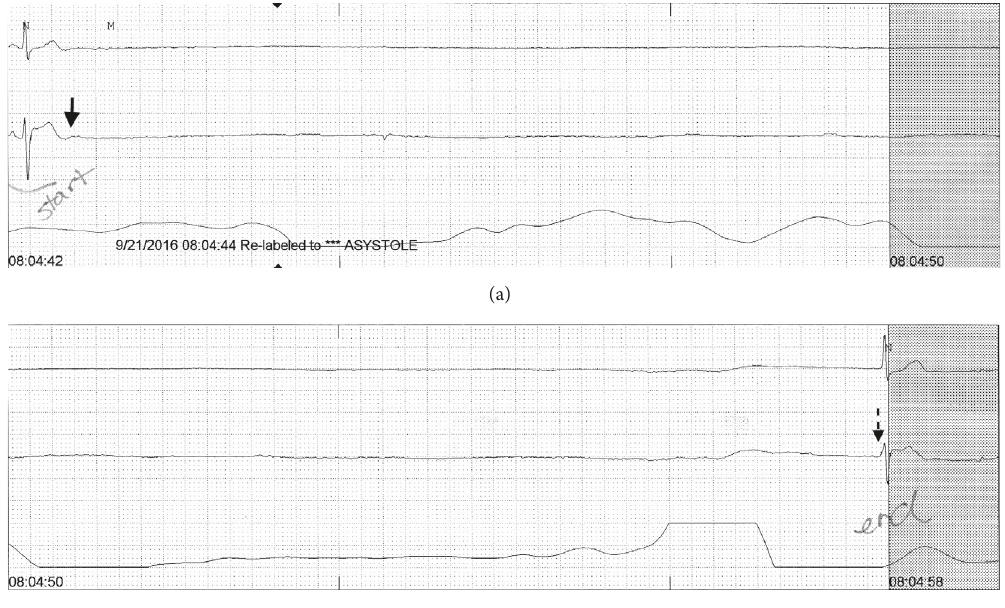
Figure 1: Telemetry monitor strips showing the duration of asystole with solid arrow pointing to the start of asystole and dotted arrow the end of asystole.